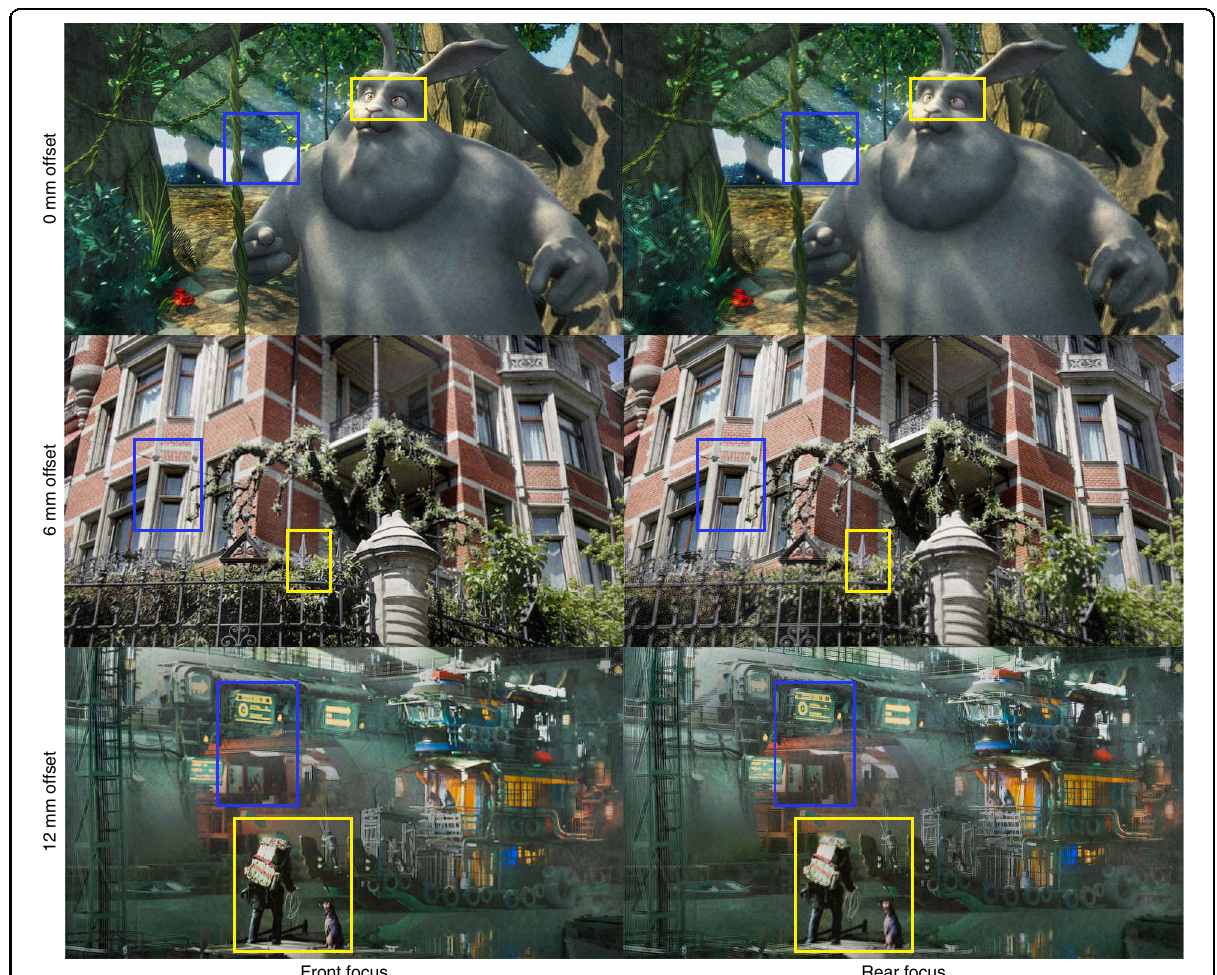
Fig. 7 Experimental demonstration of holographic 3D projections. Two computer-rendered (Top/Bottom) and one real-world captured (Middle) scenes are displayed and photographed for target holograms located at three different distances (marked on the left) to the midpoint hologram. The yellow box marks the foreground object of interest, and the blue box marks the background object of interest. Readers are encouraged to zoom in to examine the image